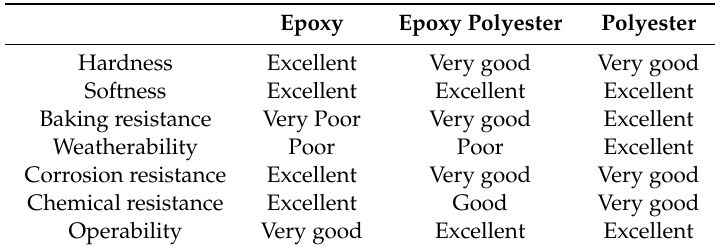
Table 1. Types and surface characteristics of resins. Epoxy Epoxy Polyester